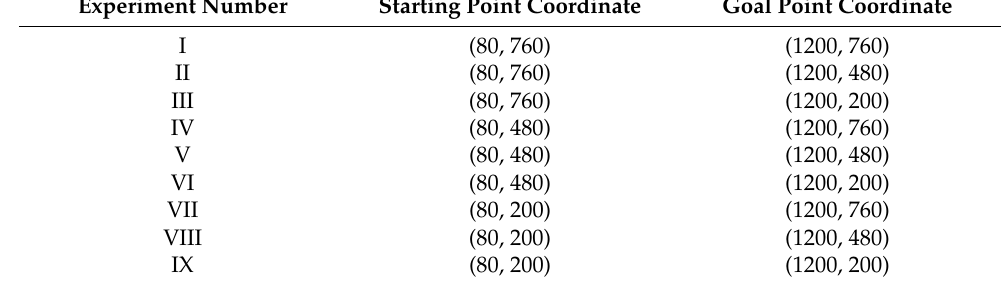
Table 8. The designated coordinates of starting and goal points for the experiments.